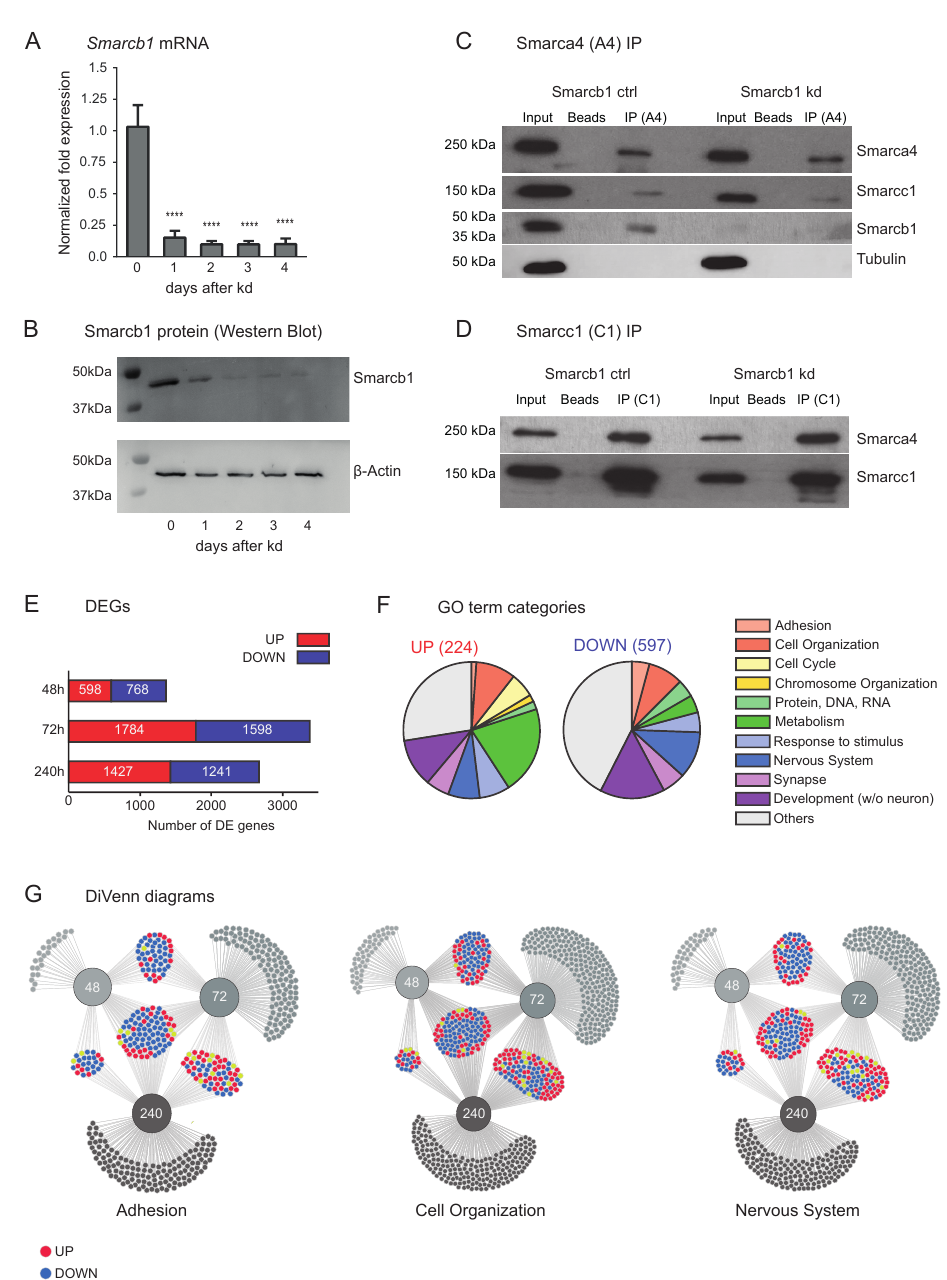
Figure 1. Smarcb1 kd impacts expression of cell adhesion -, cell organisation -, neuron system - and development -associated genes ( A ) Smarcb1 expression on mRNA level measured by RT-qPCR in n = 3 biological replicates. Error bars represent SEM, **** = p < 0.0001. ( B ) Smarcb1 signal in a representative Western blot with b-Actin as loading control. ( C , D ) Immunoprecipitation (IP) of BAF-complex core units Smarca4 (A4) and Smarcc1 (C1) from nuclear extracts of Smarcb1-positive (Smarcb1 ctrl) and Smarcb1-kd ESC. Tubulin was used as a loading control. ( E ) Number of differentially expressed genes (DEG) ( p < 0.05 and abs. log2FC > 0.58) after Smarcb1 knockdown at indicated time points in RNA-seq. ( F ) GO terms assigned to up- and downregulated genes 72 h after Smarcb1 knockdown. GO terms were manually separated into categories and overall number (in parenthesis) as well as distribution are depicted here. ( G ) Venn diagrams depict the overlap of DEG at three time-points after Smarcb1 kd (48 h, 72 h, 240 h) belonging to categories Adhesion, Cell Organisation or Nervous system. Gene lists were created by using representative GO-term gene lists (see Methods). Genes uniquely deregulated at one time point are greyed-out for